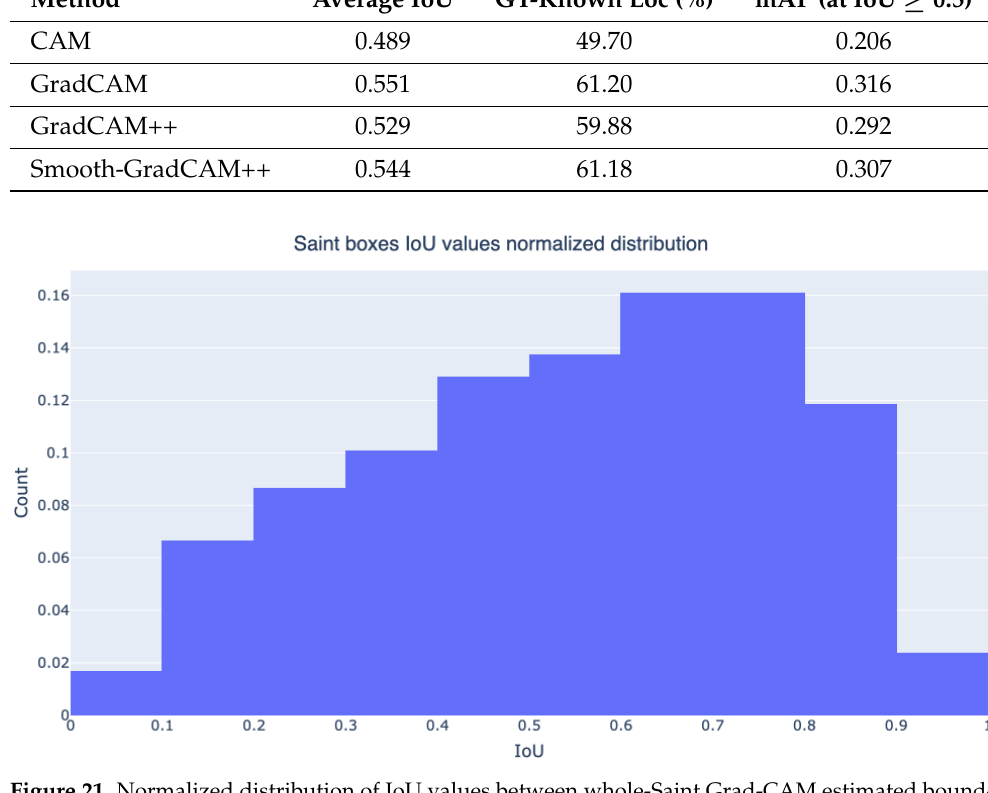
Figure 21. Normalized distribution of IoU values between whole-Saint Grad-CAM estimated bound- ing boxes and ground-truth bounding boxes. Table 4. Mean Average Precision (mAP) values for each class of the ArtDL dataset. Bounding boxes are estimated with